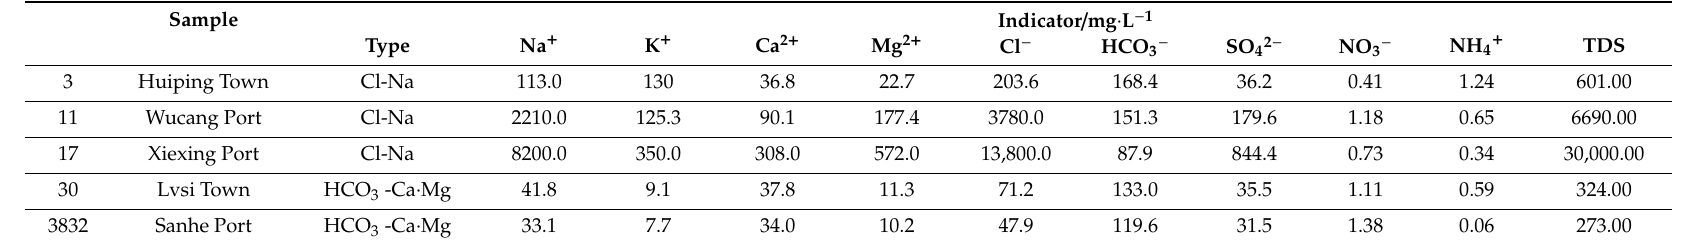
Table A1. Chemical characteristics of surface water in the study